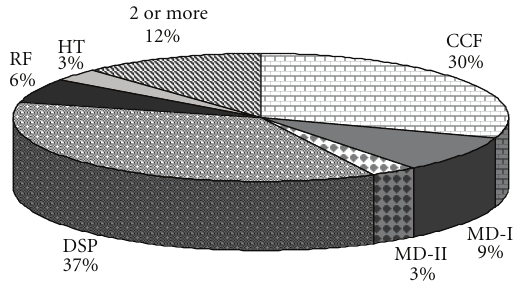
Figure 6: Associated pathologies in positive patients of Chagas Disease. CCF: chronic cardiac failure; RF: renal failure; HT: hyperthyroidism; DSP: dyslipidemia; MD-I: mellitus diabetes type 1; MD-II: mellitus diabetes type 2; 2 or more represents the combination of two or more of these